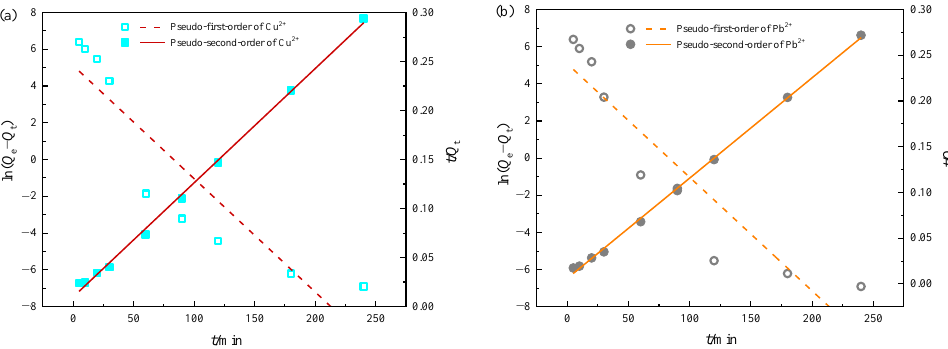
Figure 8. Adsorption kinetics of Cu(II) and Pb(II) on MOMMC ( C 0 = 1000 mg · L − 1 , pH = 5, T = 25 ◦ C, adsorbent concentration = 1 g · L − 1 ).